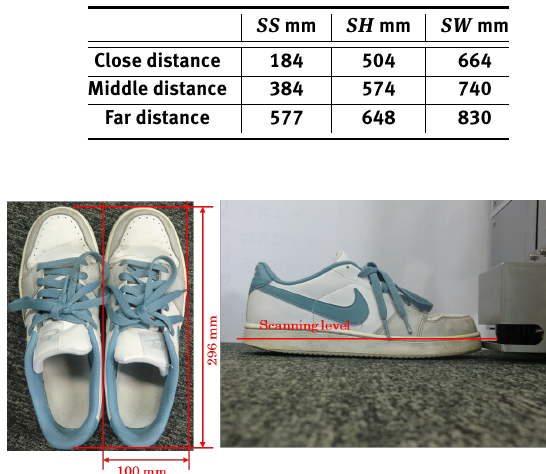
Fig. 18. Shoes used in Experiments